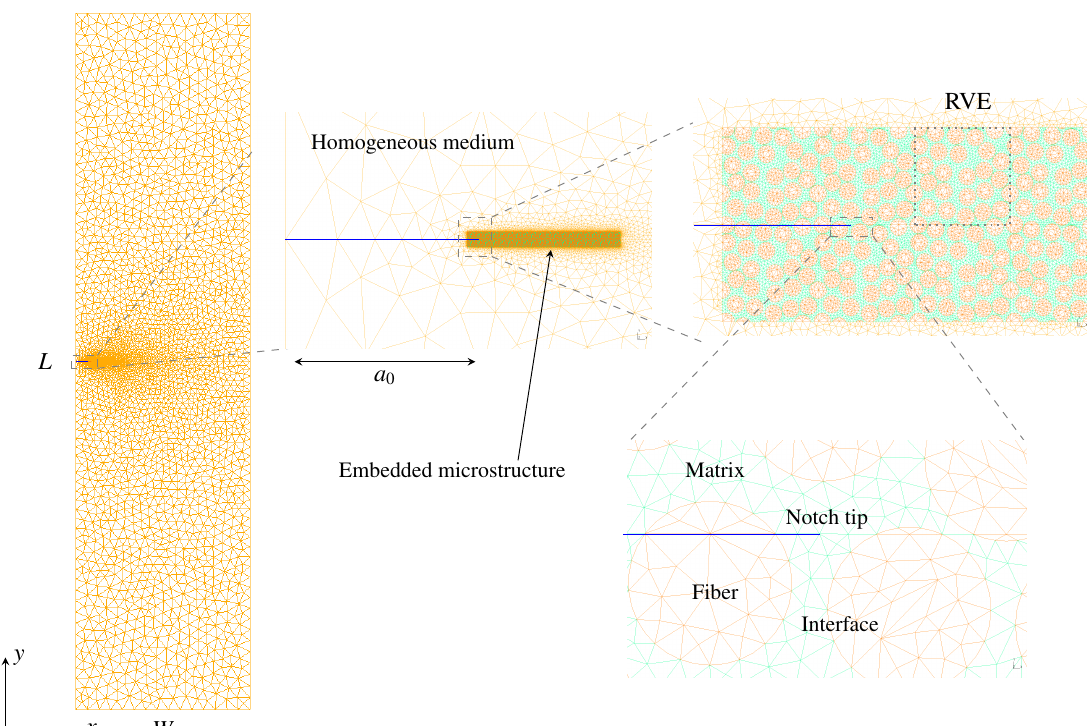
Figure 9. A finite element model of the SENT specimen. An initial notch is located on the left side of the specimen with an embedded microstructure represented by a number of repeating RVEs with stochastic fiber distributions. The dotted box on the top right shows the mesh of a RVE. Finer mesh is used for the embedded microstructure zone, and coarser mesh is used for the surrounding homogeneous medium [73].